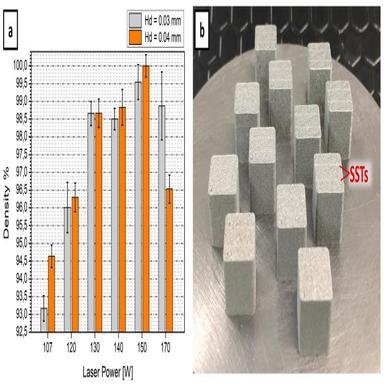
(a) Density measurement with Archimedes' method; (b) Mo blocks produced in the 2nd test for parameters tuning, indicating also the SSTs produced on top surfaces of blocks.